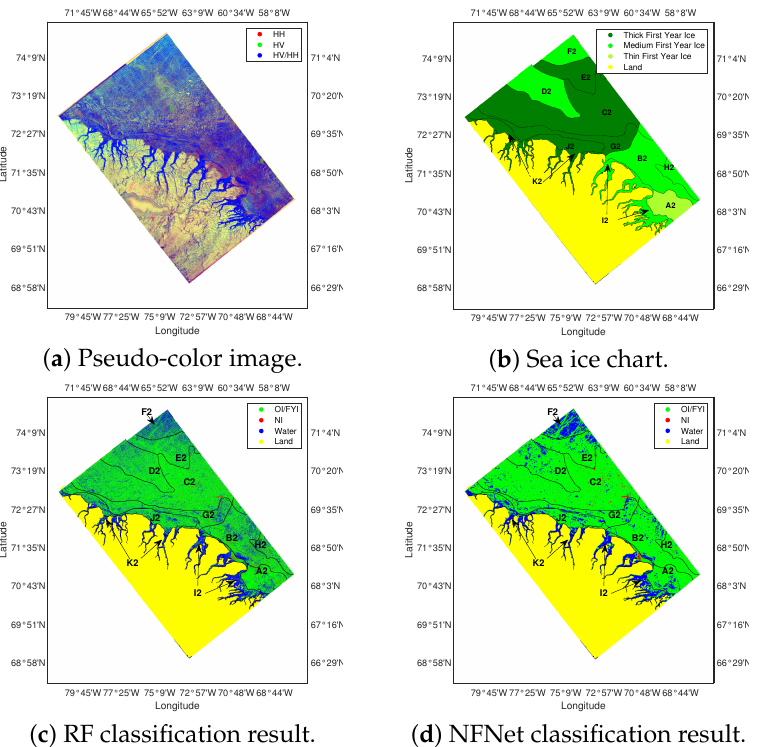
Figure 8. ( a ) Image acquired on 2 March 2021. The green rectangles display the locations of the testing samples for OI/FYI. ( b ) Sea ice chart. ( c ) RF classification result. ( d ) NFNet classification result.